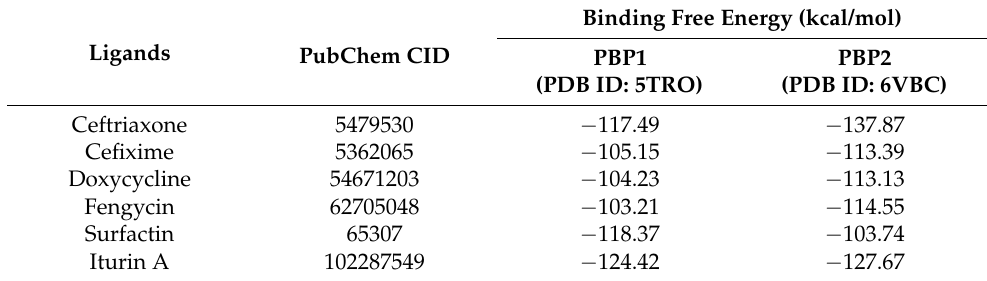
Table 3. Molecular docking analysis between surfactin, fengycin, and iturin A with receptors PBP 1 and 2.